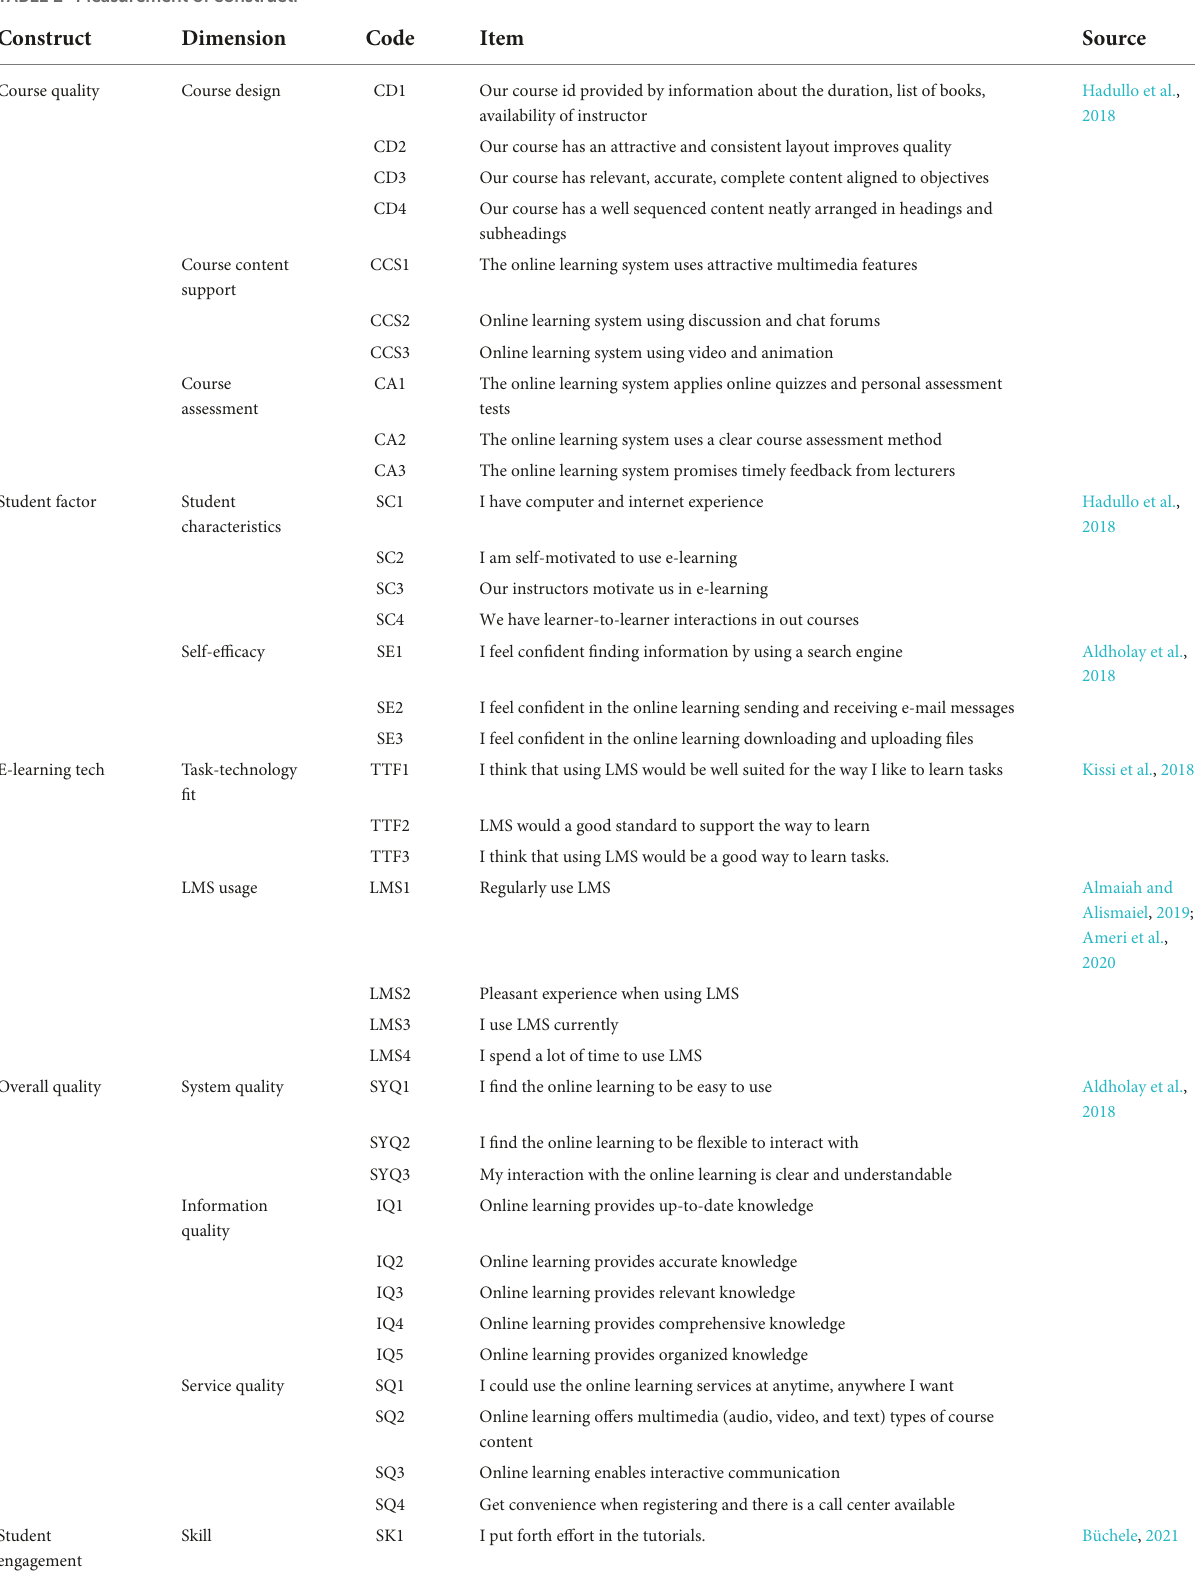
TABLE 2 Measurement of